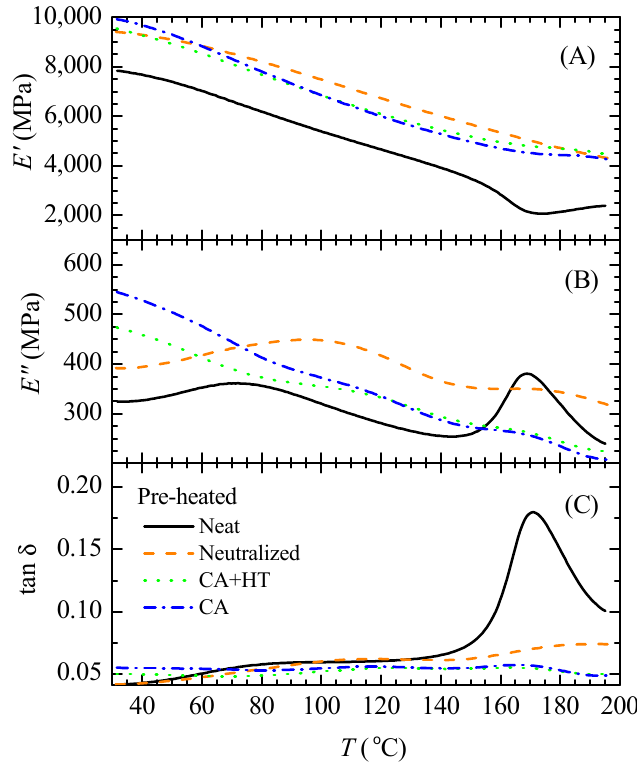
Figure 4. The plots of ( A ) storage modulus, ( B ) loss modulus, and ( C ) tan δ against temperature of preheated neat, neutralized, CA, and CA-HT films.